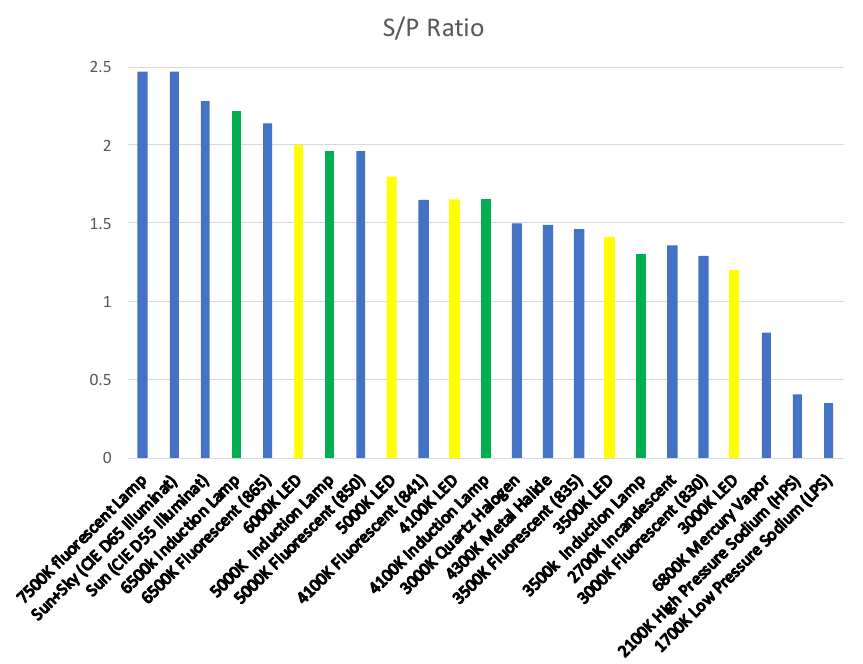
Figure 2. Scotopic / photopic ratio for various light sources. Data from Figure 2. Scotopic/photopic ratio for various light sources. Data from [7].